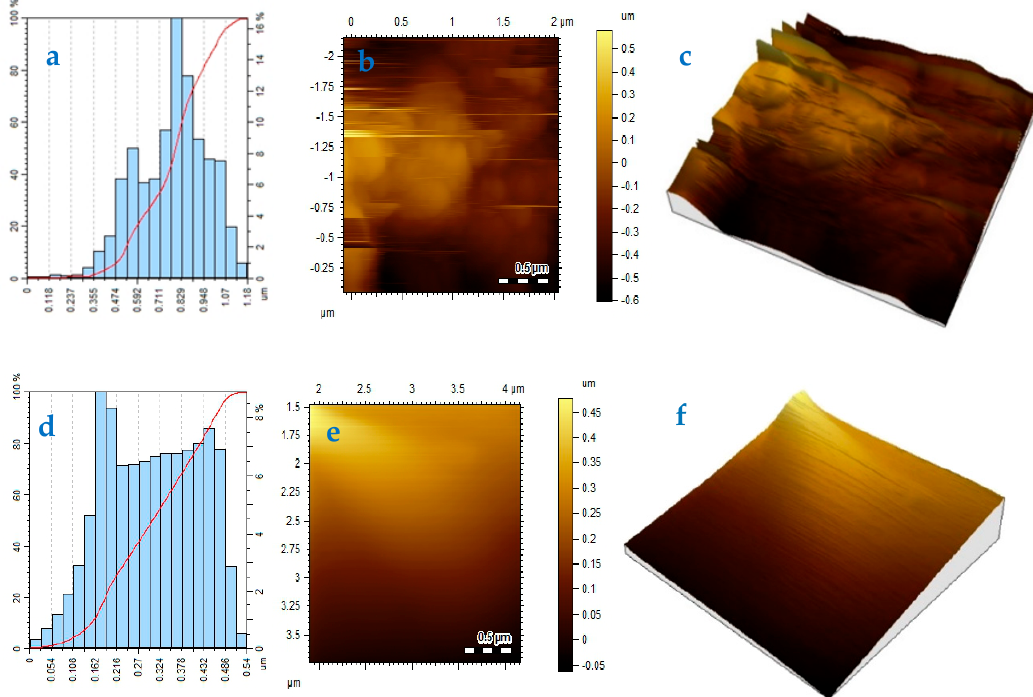
Figure 8. Height profile ( a , d ), 2D ( b , e ), and 3D ( c ) atomic force microscopy (AFM) images of SnS ( a – c ) and SnS/HDA ( d – f ) nanoparticles.